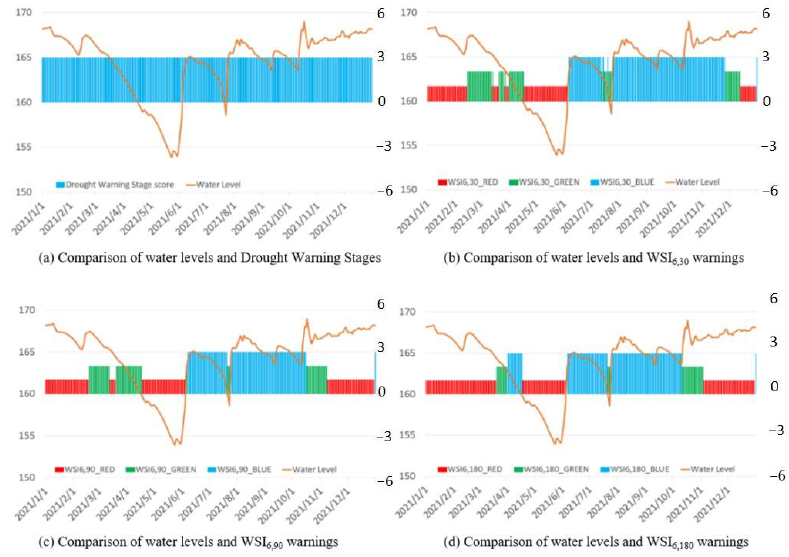
Figure 12. Comparison of the Water Conservancy Drought Warning Stage with the WSI 6,j proposed in this study.